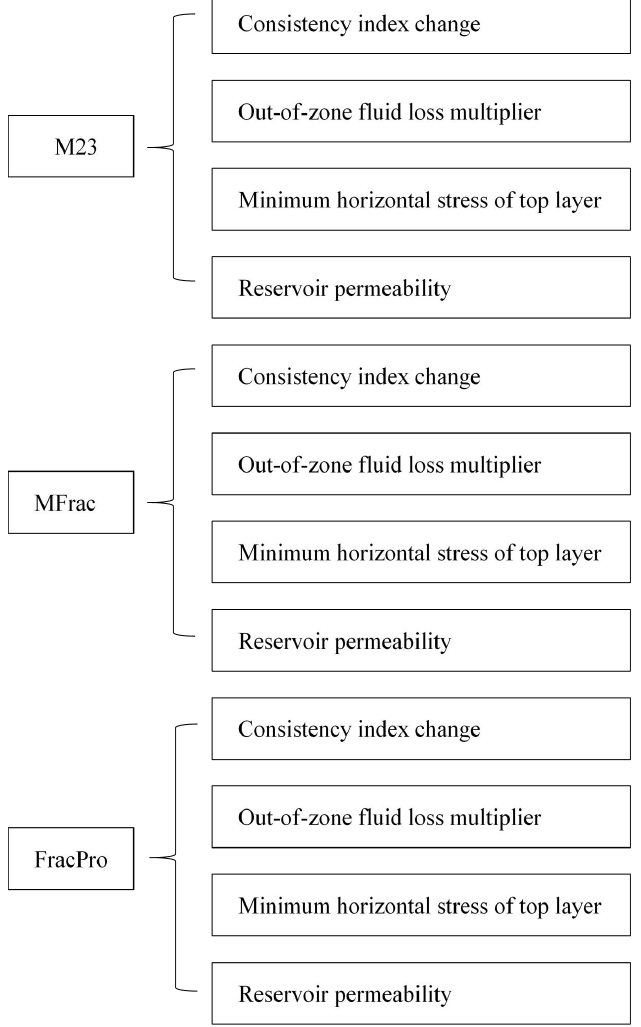
Figure 1—Project